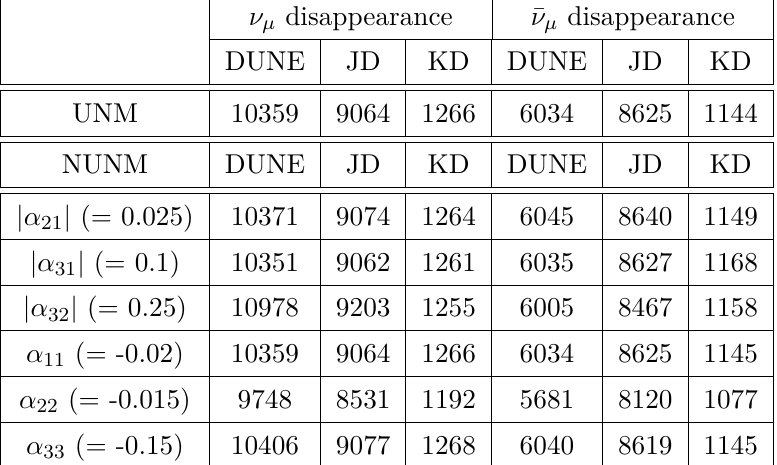
Table 5 . Comparison of the total signal rate for the ν µ and ¯ ν µ disappearance channels in DUNE, JD, and KD setups in UNM case as well as in presence of various NUNM parameters. The relevant features of these facilities are given in table 3. The values of the standard oscillation parameters used to calculate event rate are quoted in table 2. The phases associated with the off-diagonal NUNM parameters are considered to be